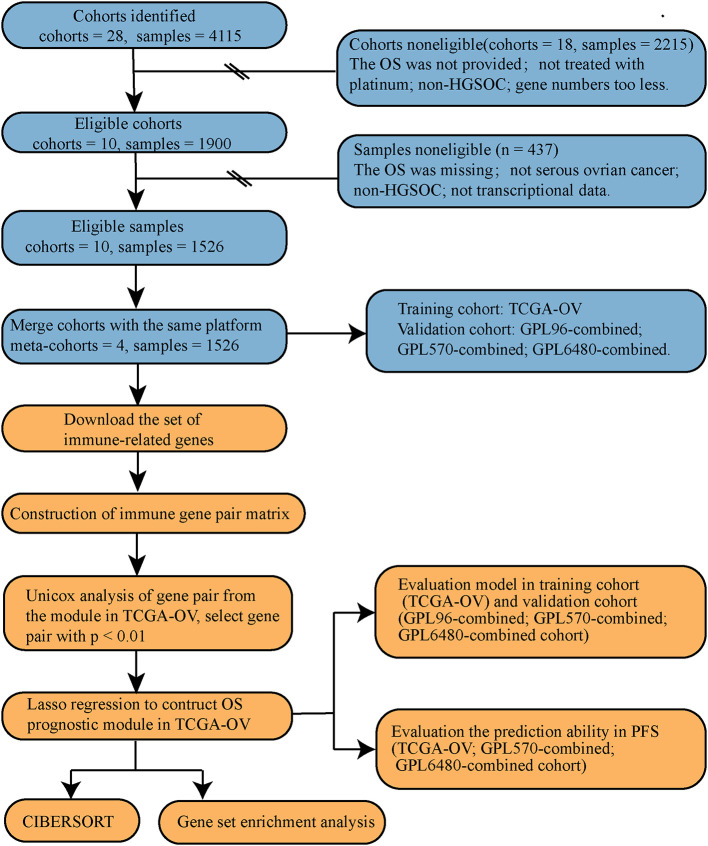
Data processing and research process.